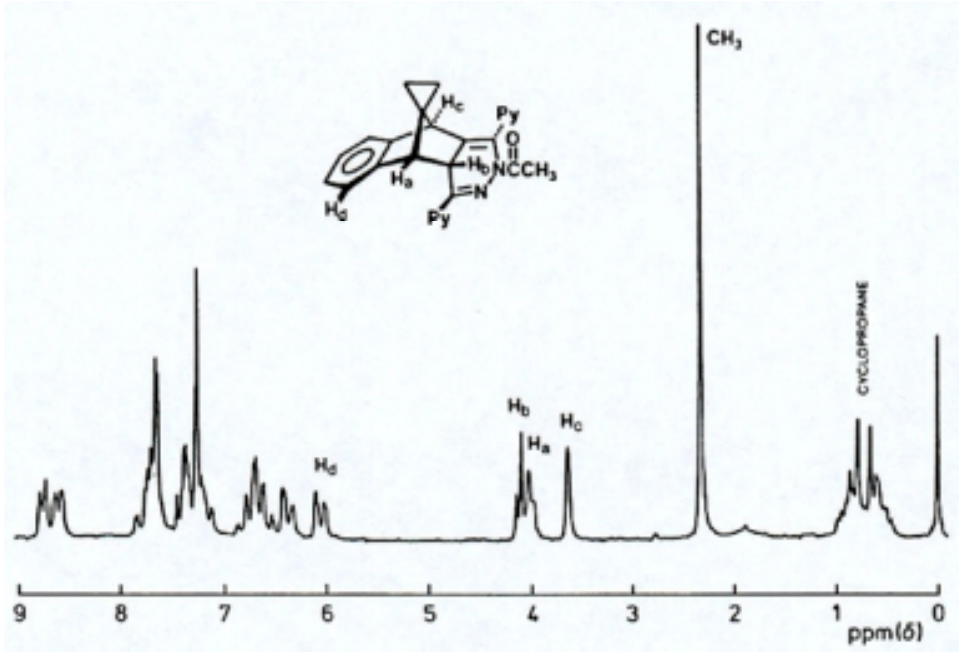
Figure 5. 1 H-NMR spectrum (80 MHz; CDCl